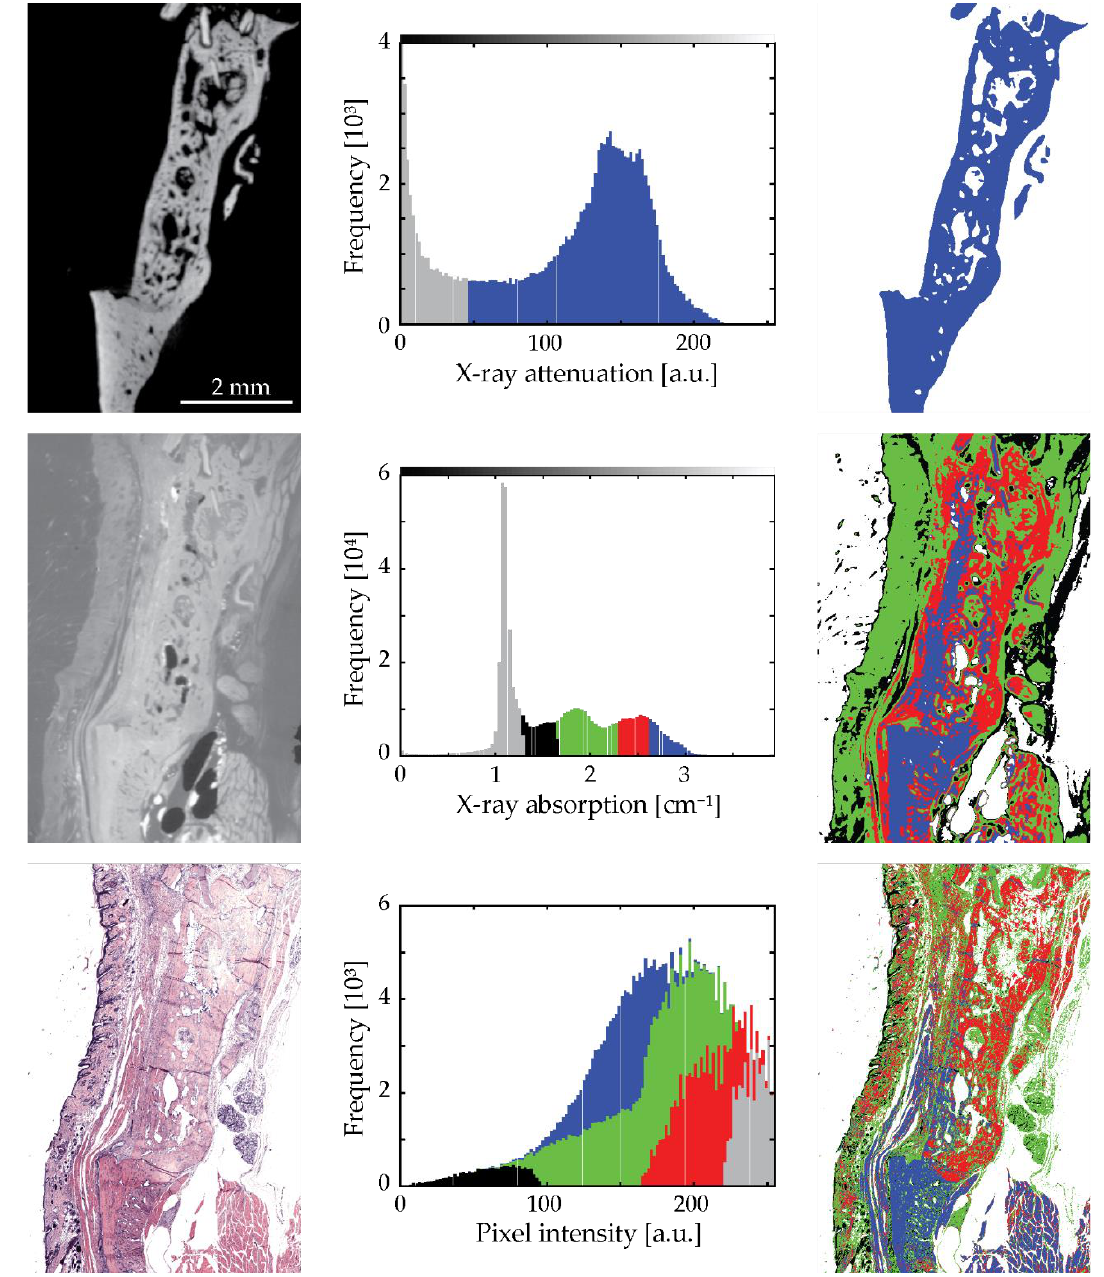
Figure 9. Tomography slices in the left column were registered to the selected histology slice, resulting in a common area for the three modalities. Individual histograms in the second column were analyzed using k-means clustering and colored accordingly. Note: frequencies were not scaled equally, and the histogram in the top row was scaled to highlight the bone peak. The histogram for the histology slice represents grayscale intensity, while clustering was performed in the RGB color space. Note the resemblance of the segmented slices in the third